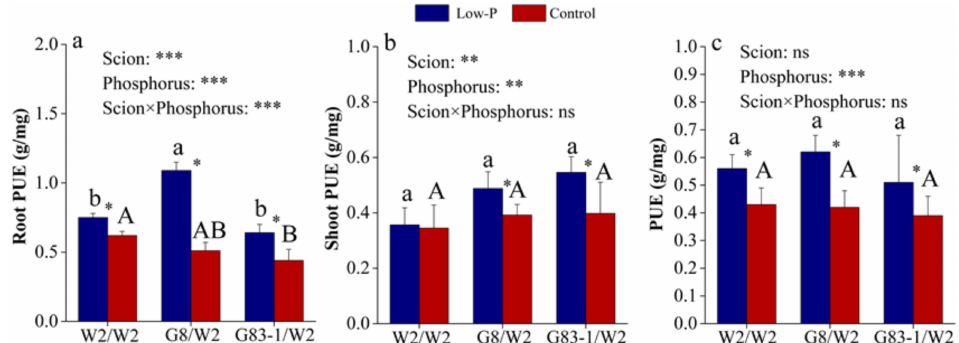
Figure 4. Root P utilization efficiency (Root PUE) ( a ), shoot P utilization efficiency (Shoot PUE) ( b ), and P utilization efficiency (PUE) ( c ) of the scions (W2, G8, and G83-1) grafted onto W2 rootstock under control (0.5 mM) and low-P (0 mM) conditions during eight months. Lowercase and uppercase indicate significant differences among the grafted combination under controls and low-P supply treatments, respectively. * on the bar indicated significant differences between control and low-P treated plants according to the one-way ANOVA test ( α = 0.05%). ** and *** in the figure legend indicated significant effect of Scion, P, and their interaction at level of p ≤ 0.01 and p ≤ 0.001, respectively. ns, no significant different between